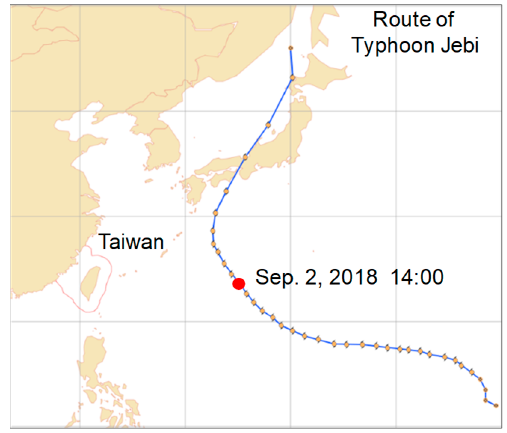
Figure 5. Route of Typhoon Jebi in 2018.